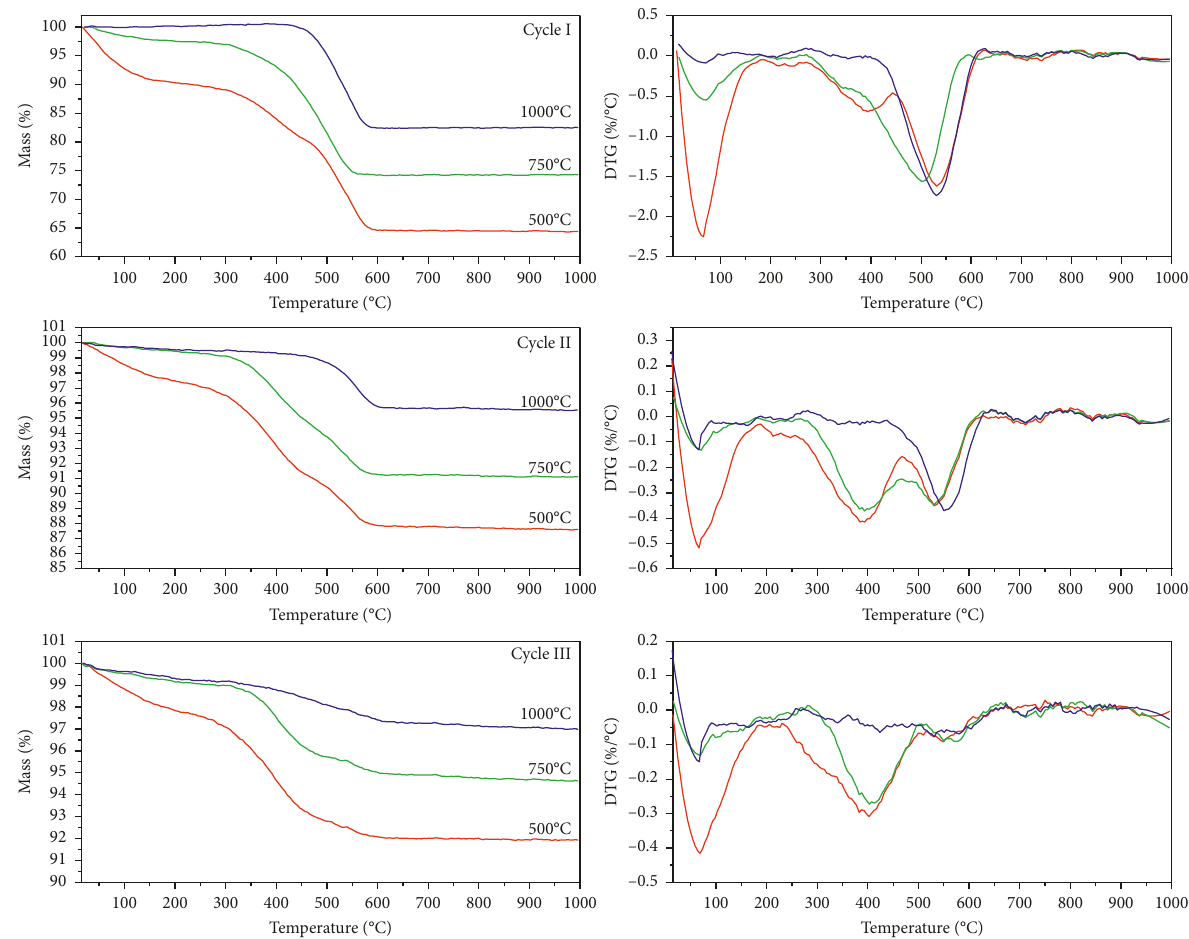
Figure 8: TGA and DTG curves of TiO and 1000 ° C.